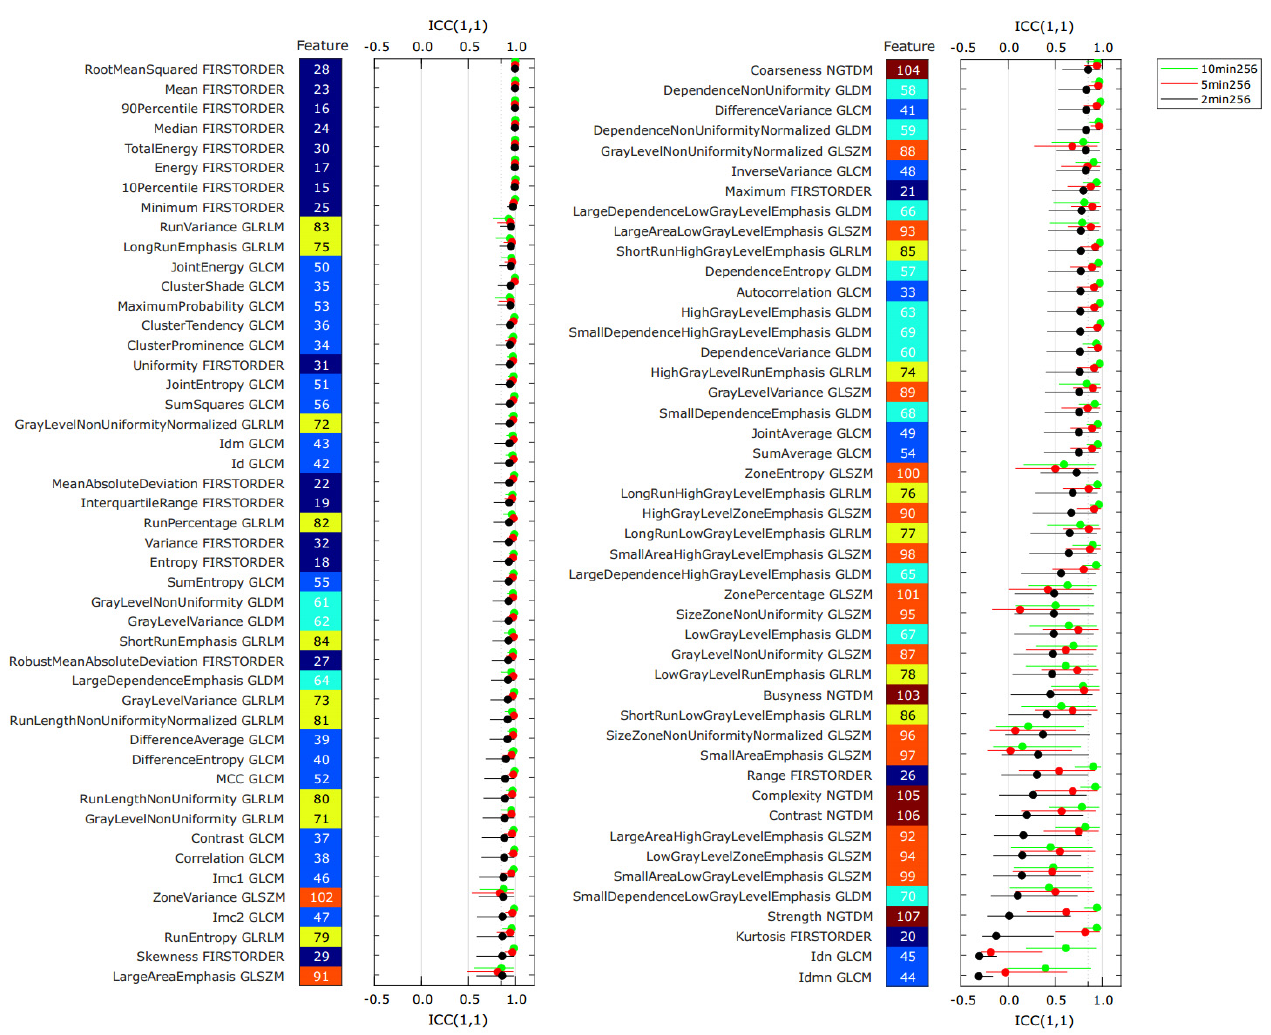
Figure 3. Intraclass coefficient ICC(1,1) for all radiomics features from the PET images in the repeata- bility dataset. For each feature, three values of ICC(1,1) are plotted: binning time 10 min (green), 5 min (red), and 2 min (black). Error bars indicate the 95% confidence intervals of the ICC values. The results are sorted in descending value of ICC(1,1) for the 2 min binning time (black circles). The feature class of each feature is indicated by the color of the tiles (dark blue: first order, light blue: